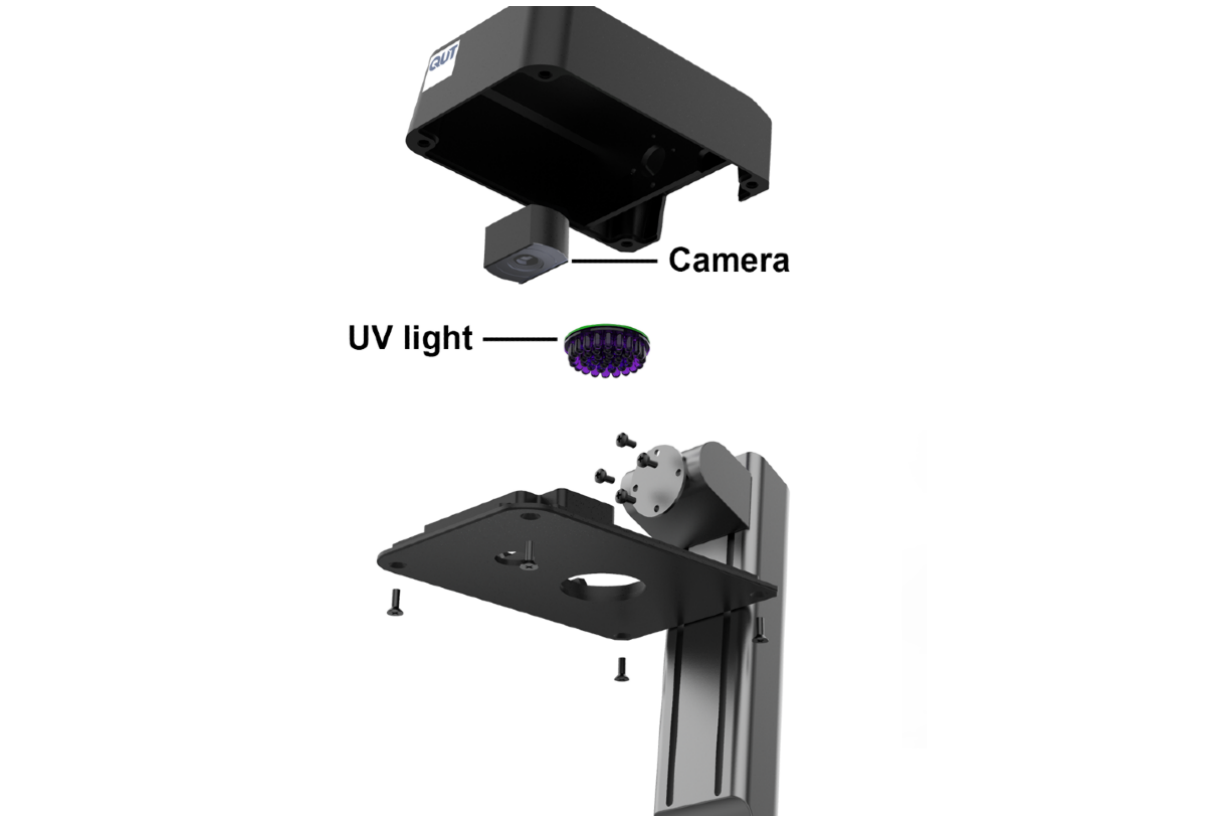
Figure 1. Smart handwashing station with electrical components housed within the top box.